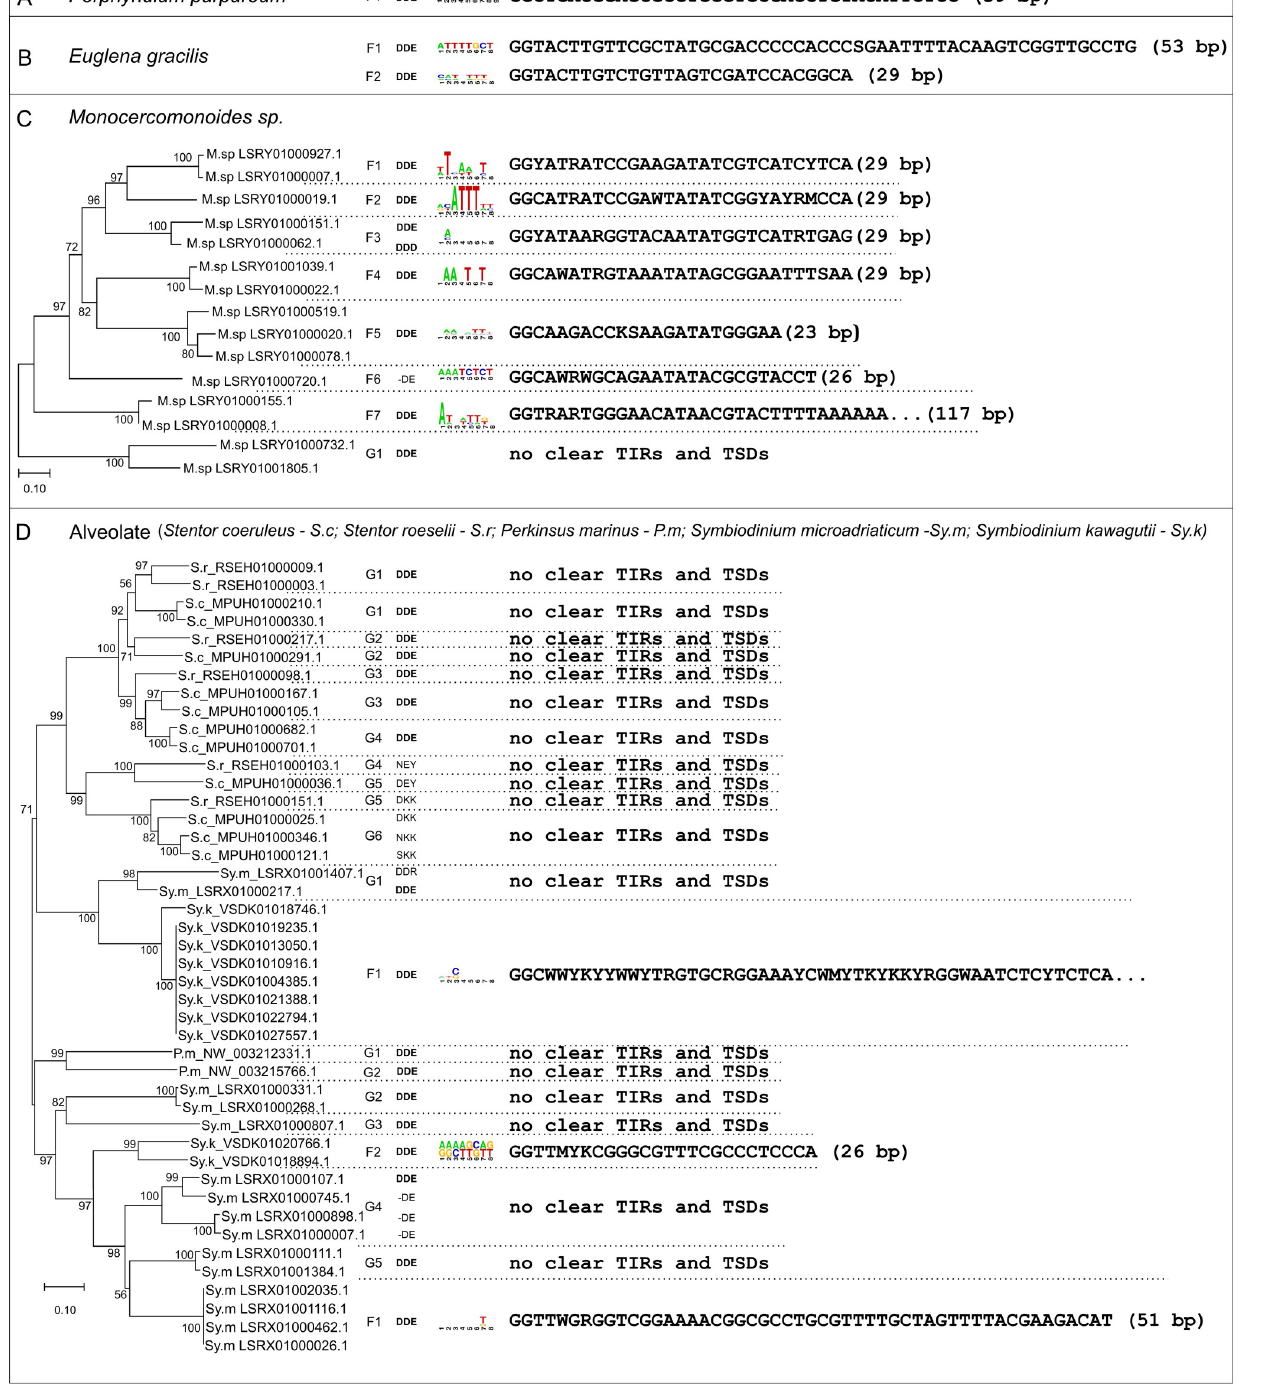
Fig 2. Main characteristics of Merlin sequences that were identified in this work. Similar Merlin copies within the same species sharing TIR sequences were grouped into families and identified by the letter F followed by a number. Groups of sequences within the same species with no TIRs and TSDs were divided according to the nucleotide divergence and identified by the letter G followed by a number. The residues aligned in the positions of the DDE motif are shown, and its conservation is highlighted in bold. TSD logos are shown and represent the nucleotide usage at each position and the y-axis ranges from a bit score of zero to two. TIR sequences are also shown and represented by both the 5’ TIR and the reverse complement of the 3’ TIR. Sequences are majority-rule consensus derived from the alignment of multiple copies of each family or individual copies in some cases and the mismatches between the